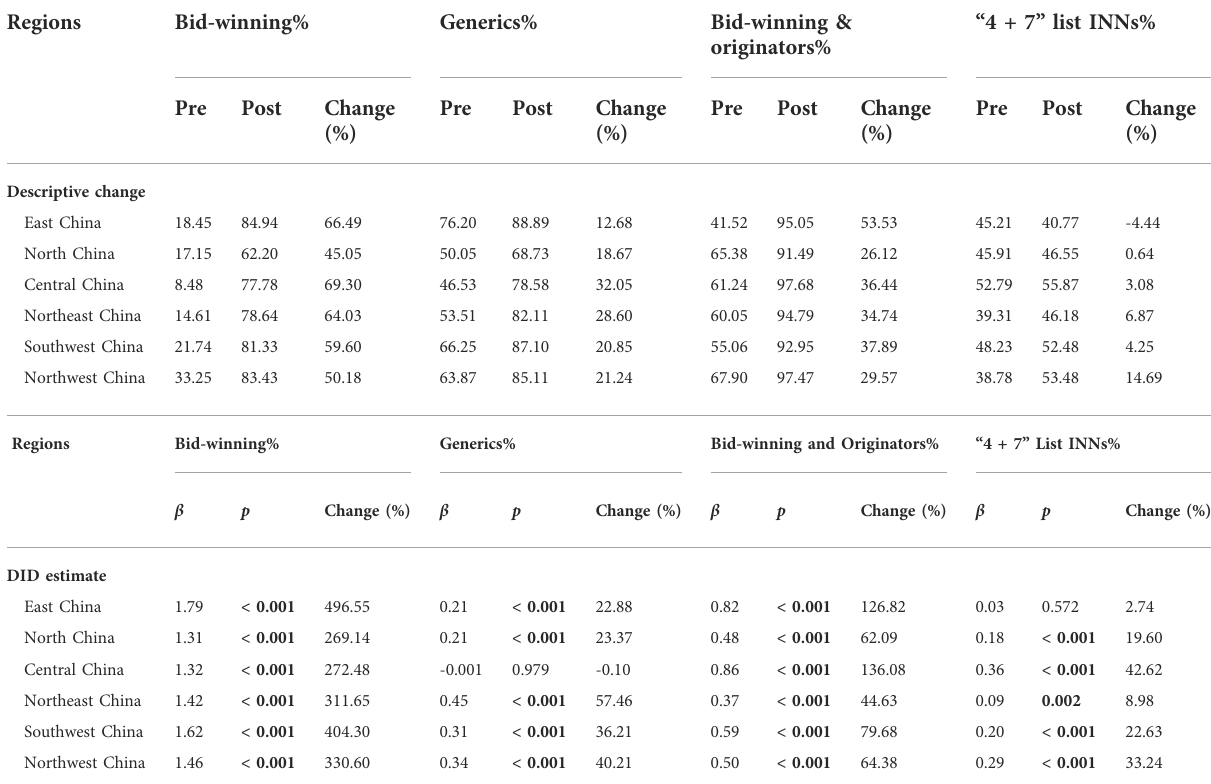
TABLE 5 Subgroup analyses on the impacts of “ 4 + 7 ” pilot on drug use structure by geographical region.